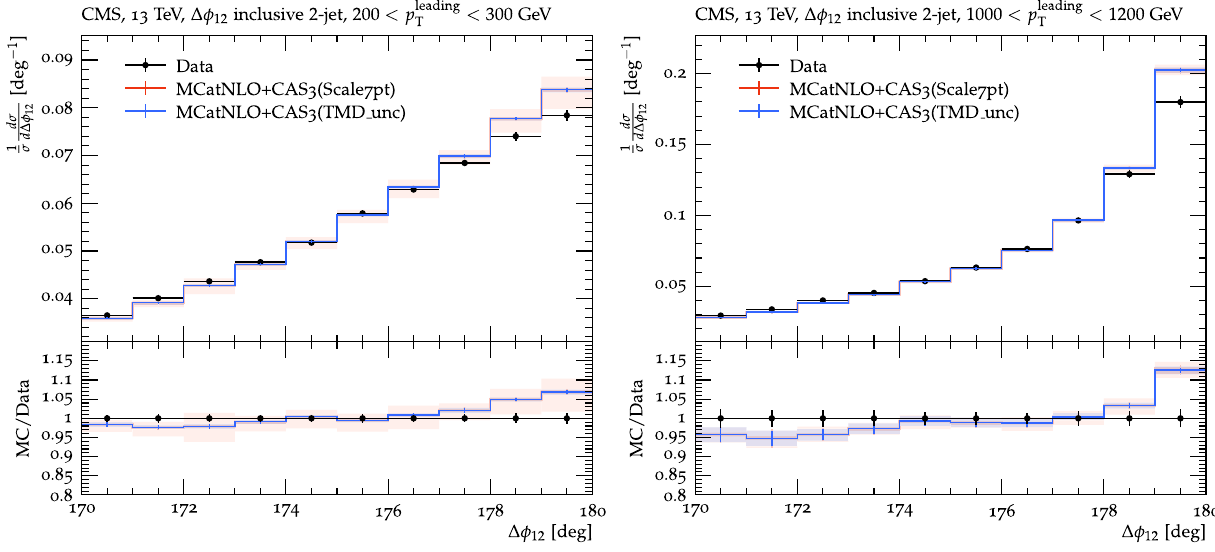
Fig. 5 Azimuthal correlation (cid:2)φ 12 in the back-to-back region for Shown are the uncertainties coming from the scale variation (as > 200 GeV (left) and p leading > 1000 GeV (right) as mea- described in the text) as well as the uncertainties coming from the p leading T T sured by CMS [27] compared with predictions from MCatNLO+CAS3.